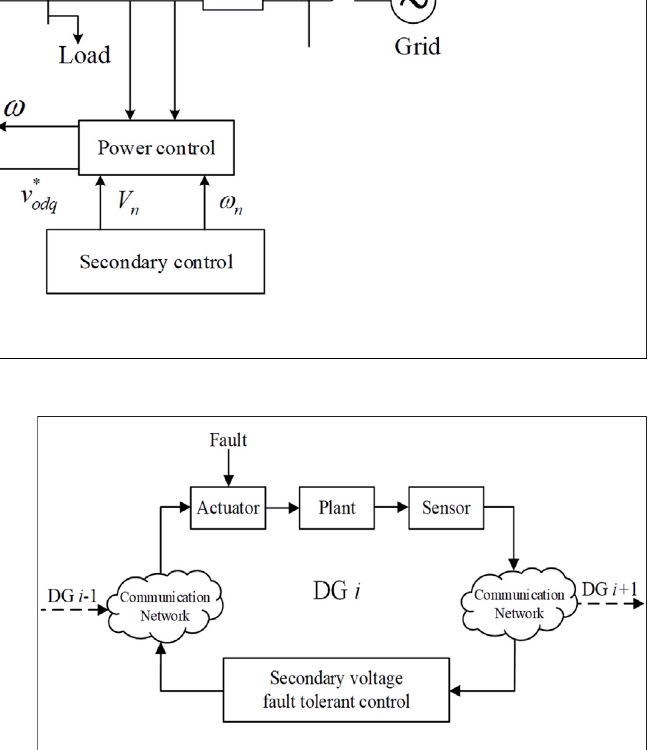
FIGURE 3 | Structure of i th MG with the actuator